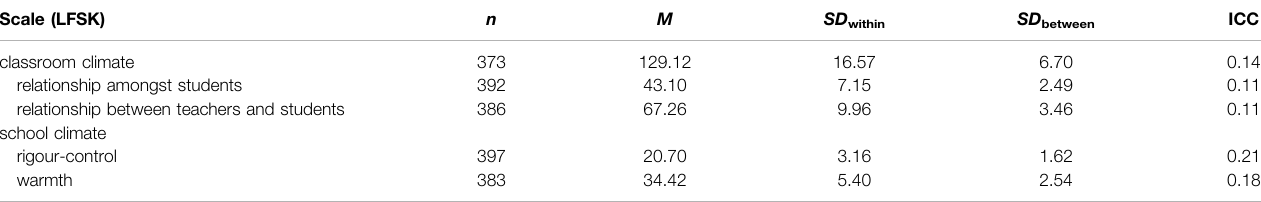
TABLE 5 | ICC, means and standard deviations of the outcome measures. Scale (LFSK) n M